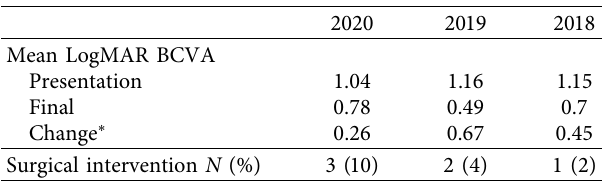
Table 3: Outcomes.